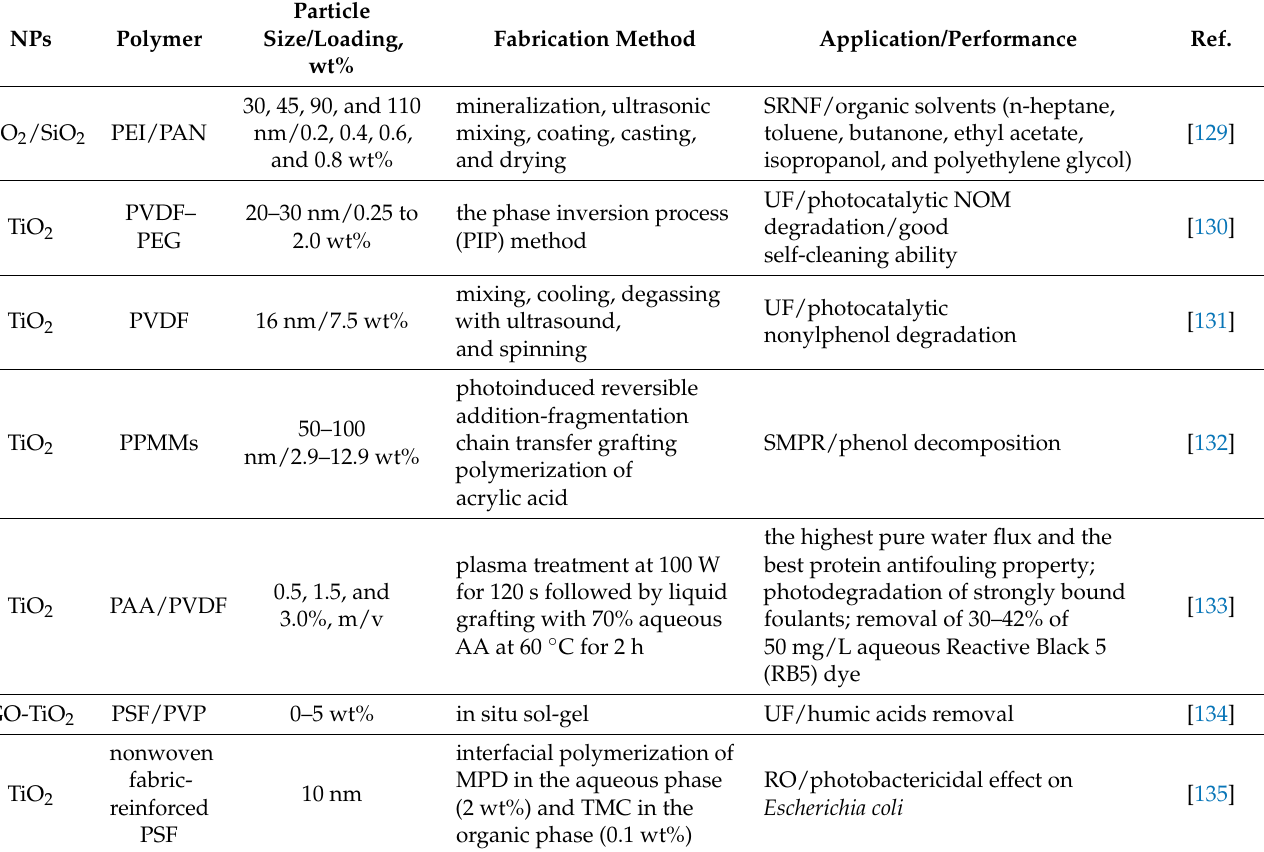
Table 5. Select applications of various types of titanium in